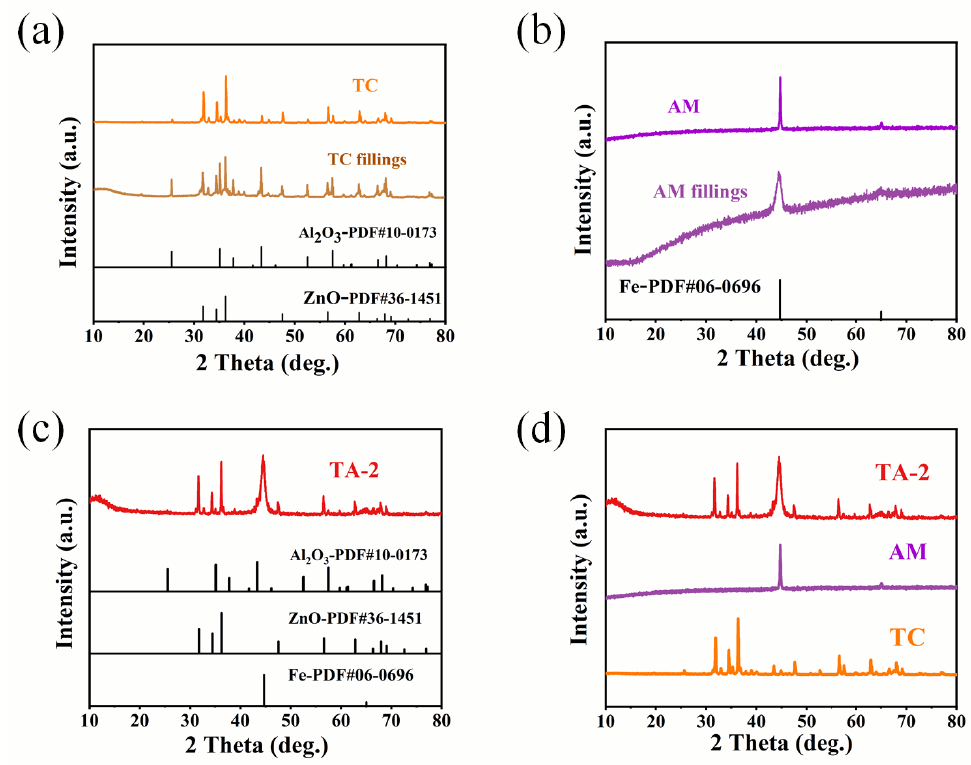
Figure 4. XRD patterns of the composites and their fillers: ( a ) TC; ( b ) AM; ( c ) TA-2; ( d ) comparison of the three composites.